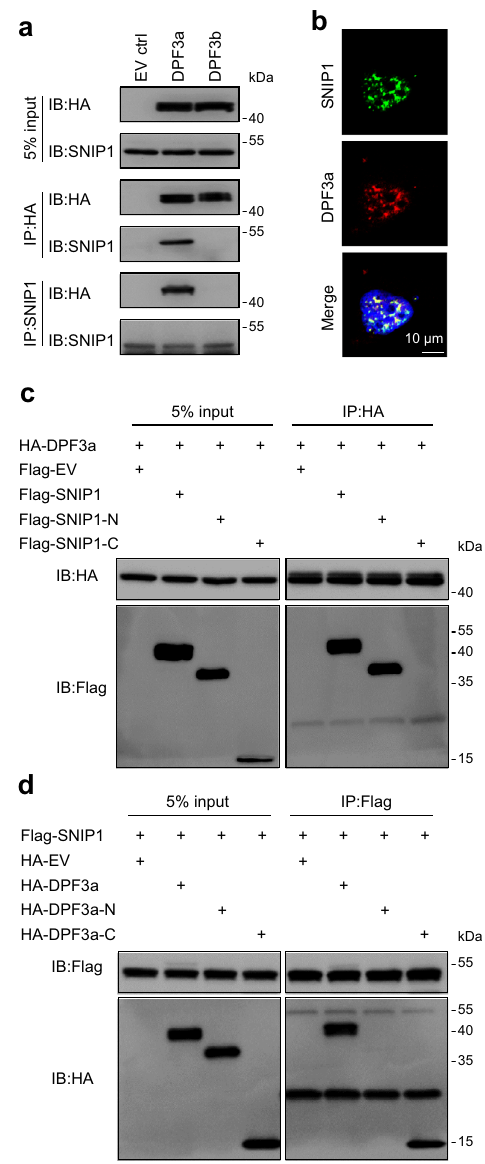
Fig. 4 | Interaction between DPF3a and SNIP1. a DPF3a interacted with SNIP1. Immunoprecipitation was carried out using antibody against HA or SNIP1, followed by immunoblotting (IB) to detect endogenous SNIP1 using anti-SNIP1 antibody or HA-tagged DPF3a/b using the anti-HA antibody in 786-O cells expressing empty vector, HA-tagged DPF3a or HA-tagged DPF3b. Input lanes represents 5% of total protein lysate. b Co-localization of DPF3a and SNIP1 in thenucleus.786-OcellsexpressingHA-taggedDPF3awere fi xedwithmethanol and stained with antibodies against HA (red) and SNIP1 (green). Scale bar, 10 μ m. c DPF3a interacted with the N-terminal domain of SNIP1. HA-tagged DPF3a were co-transfected separately with Flag-tagged full-length SNIP1 or its C-/N- terminus in HEK293T cells. HA-tagged DPF3a was puri fi ed by immuno- precipitation with anti-HA magnetic beads, followed by immunoblotting to detect Flag-tagged SNIP1 truncations with the anti-Flag antibody. d SNIP1 interacted with the C-terminus of DPF3a. Flag-tagged SNIP1 were co- transfected separately with full-length HA-tagged DPF3a or its C-/N- terminus in HEK293T cells. Flag-tagged SNIP1 was puri fi ed by immunoprecipitation with anti-Flag magnetic beads, followed by immunoblotting to detect HA-tagged DPF3a with the anti-HA antibody. a – d Three independent experiments were performed and similar results were obtained. Source data are provided in the Source Data fi